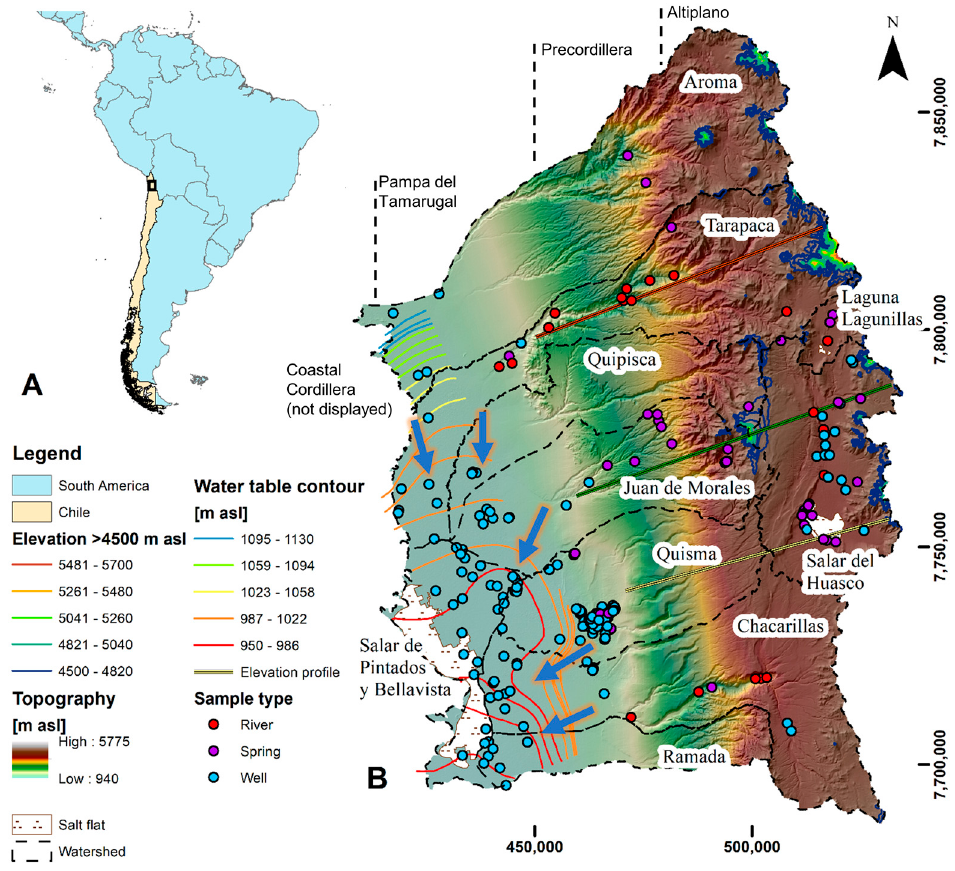
Figure 1. ( A ) View on South America (black rectangle represents the extent of Figure 1B), ( B ) Topographical map of the study area and sample types (elevation profiles are discussed in Section 5.2). Water table contour lines indicate the regional groundwater flow regime of the PdT Aquifer and are based on Jica [2]. Arrows indicate resulting groundwater flow directions. Not all springs in the region are displayed.